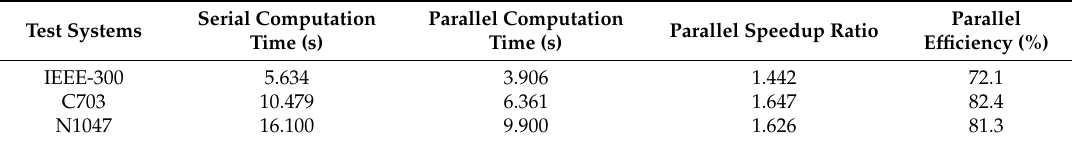
Table 4. Parallel Performance of Novel PLF